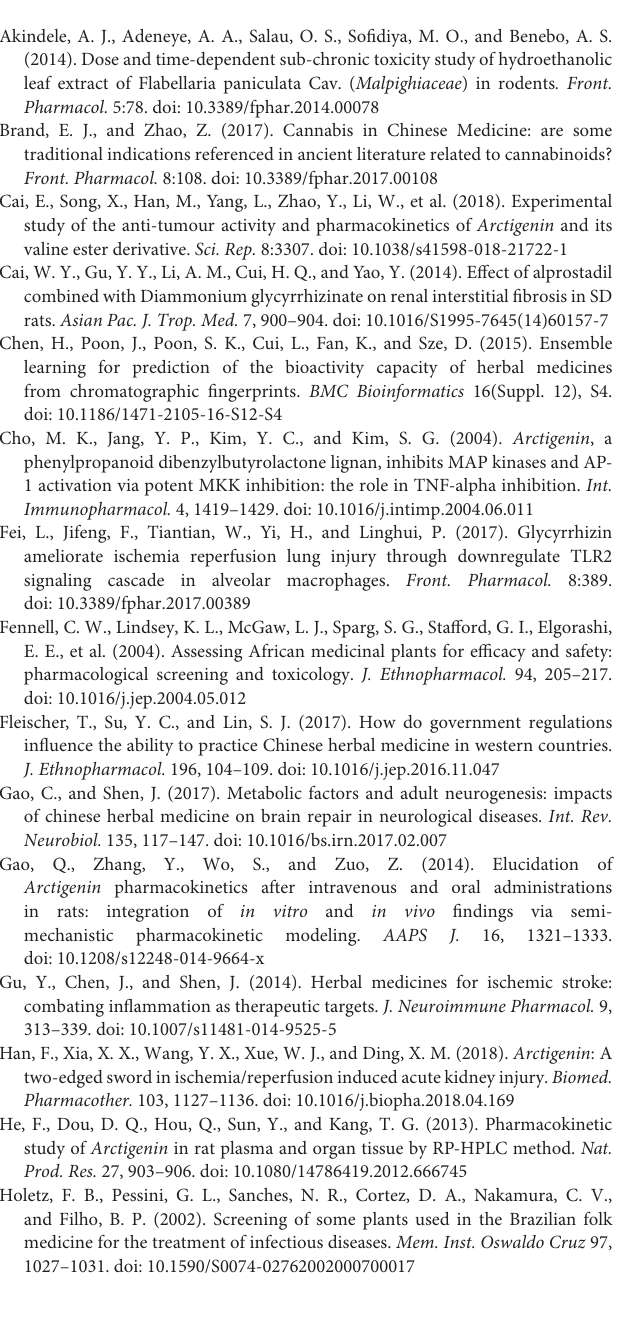
Table S1 | The body weights (g) of Arctigenin (12-, 36-, and 120 mg/kg) administration by gavage (i.g) in rats during exposure period ( n = 30, 15 female, 15 male) and recovery period ( n = 10, 5 female, 5 male per treatment group, results were presented as Mean ± SD). Table S2 | The food consumption (g/cage ∗ 24h) of Arctigenin (12-, 36-, and 120 mg/kg) administration by gavage (i.g) in rats during drug exposure period ( n =